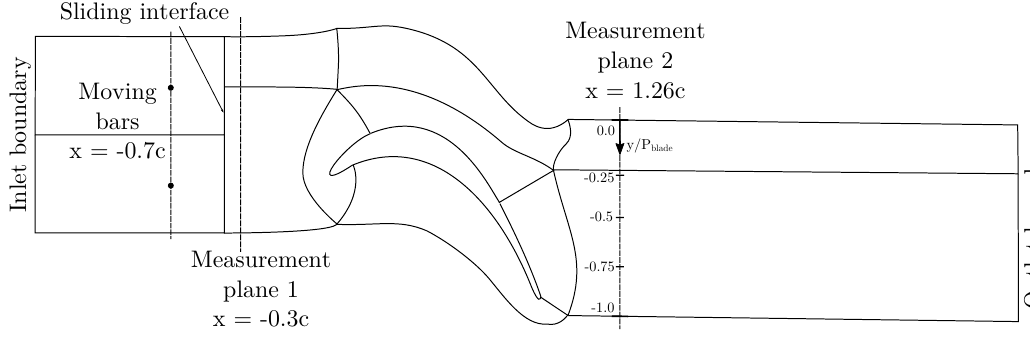
Figure 1. Setup of the linear low-pressure turbine with two wake-generating bars